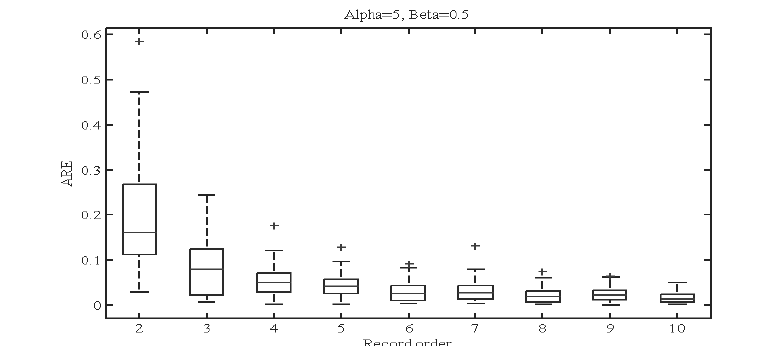
Figure 4 – Skewness coefficient of records.